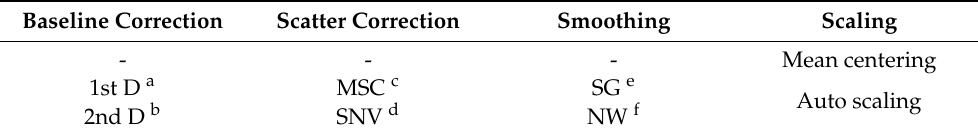
Table 2. Overview of some commonly used algorithms for each pretreatment method.